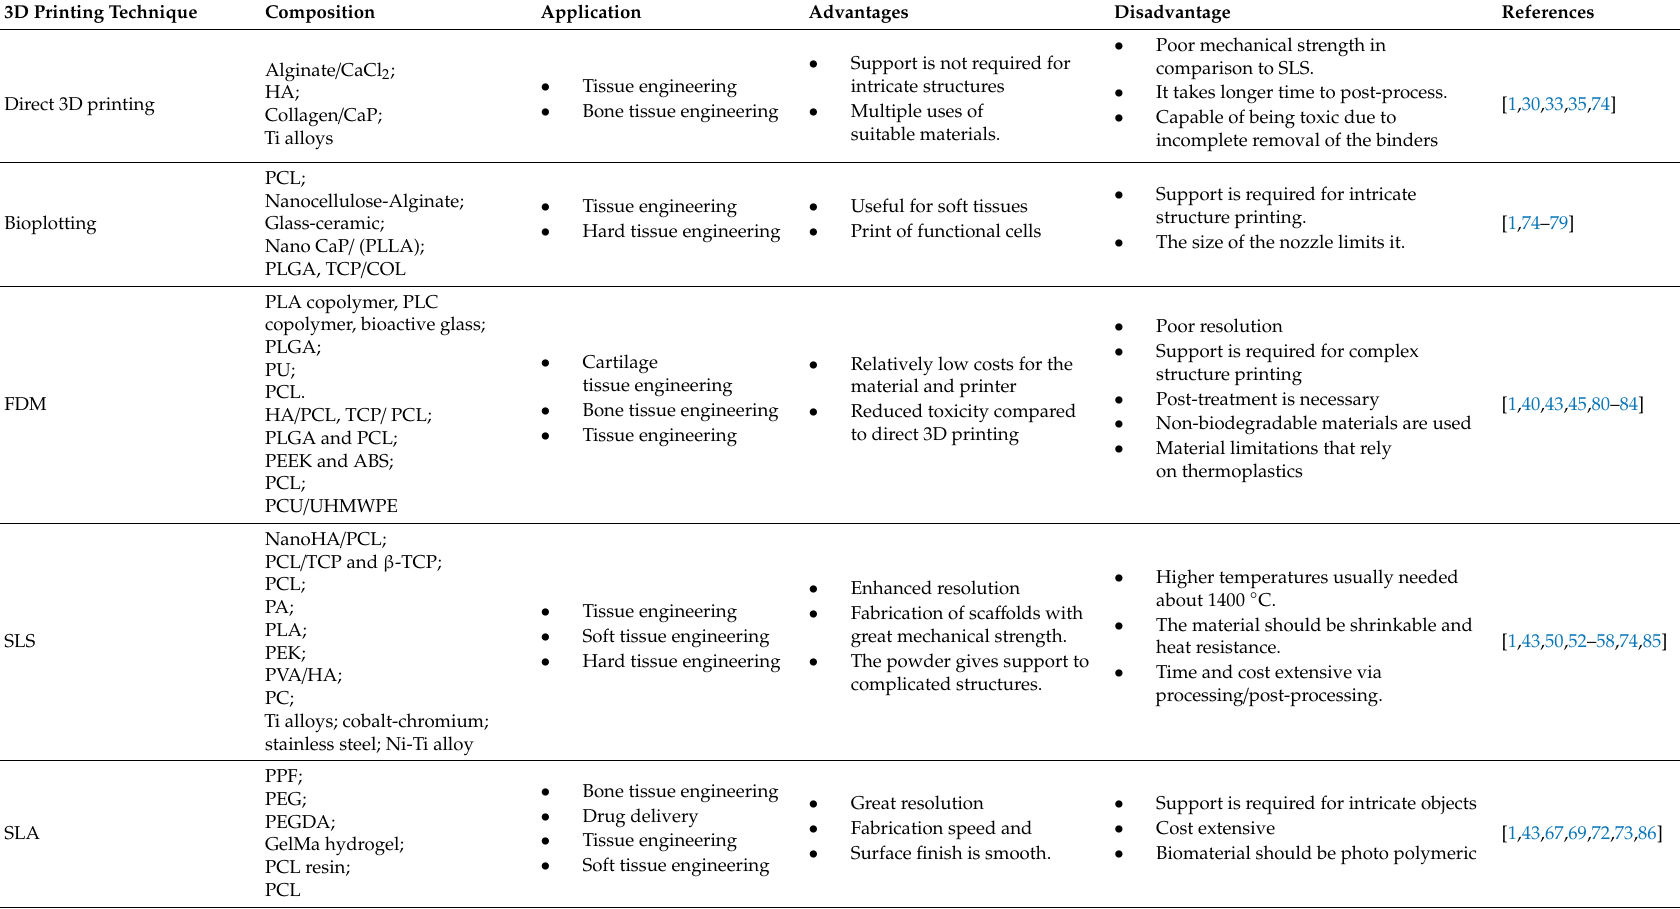
Table 1. 3D printing applications and the comparison of various techniques used in sca ff old printing for tissue